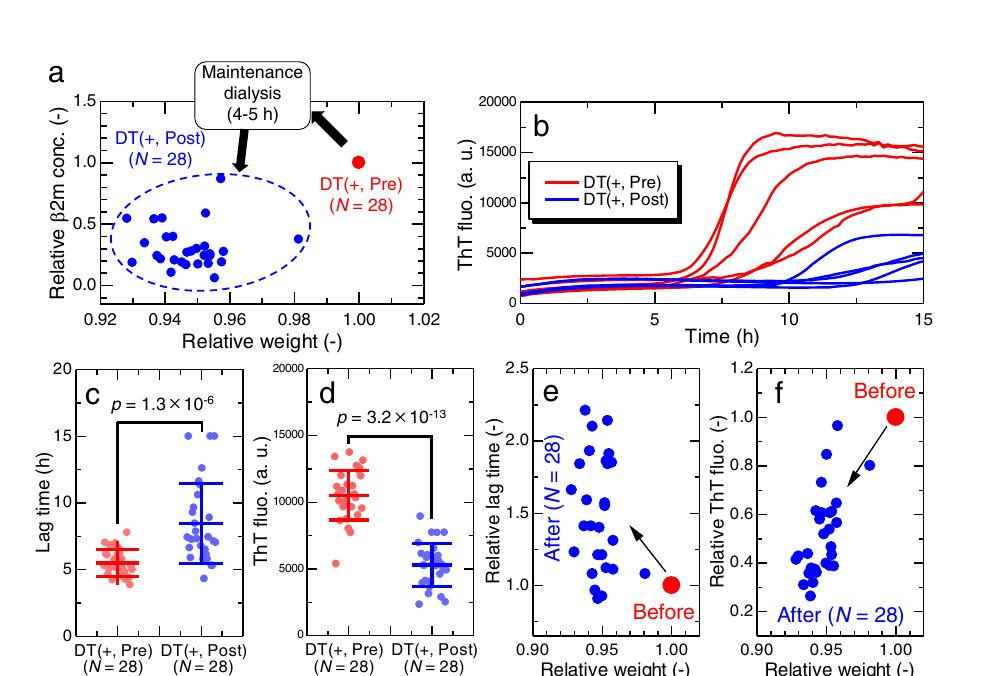
Fig. 4 | Amelioration of inhibitory effects by maintenance dialysis. a Effects of maintenance dialysis treatment on the serum β 2m concentration and body weight of dialysis patients ( N =28), who donated their serum immediately before (DT(+, Pre))andafter(DT(+,Post))maintenancedialysistreatment.Therelativechangesin the two parameters were shown with respect to their values before dialysis treat- ment. b ThT fl uorescencekinetics of β 2m fi bril formation with 5%(v/v) addition of sera collected from an identical dialysis patient immediately before (DT(+, Pre), #15) and after (DT(+, Post), #15) a single maintenance dialysis treatment.